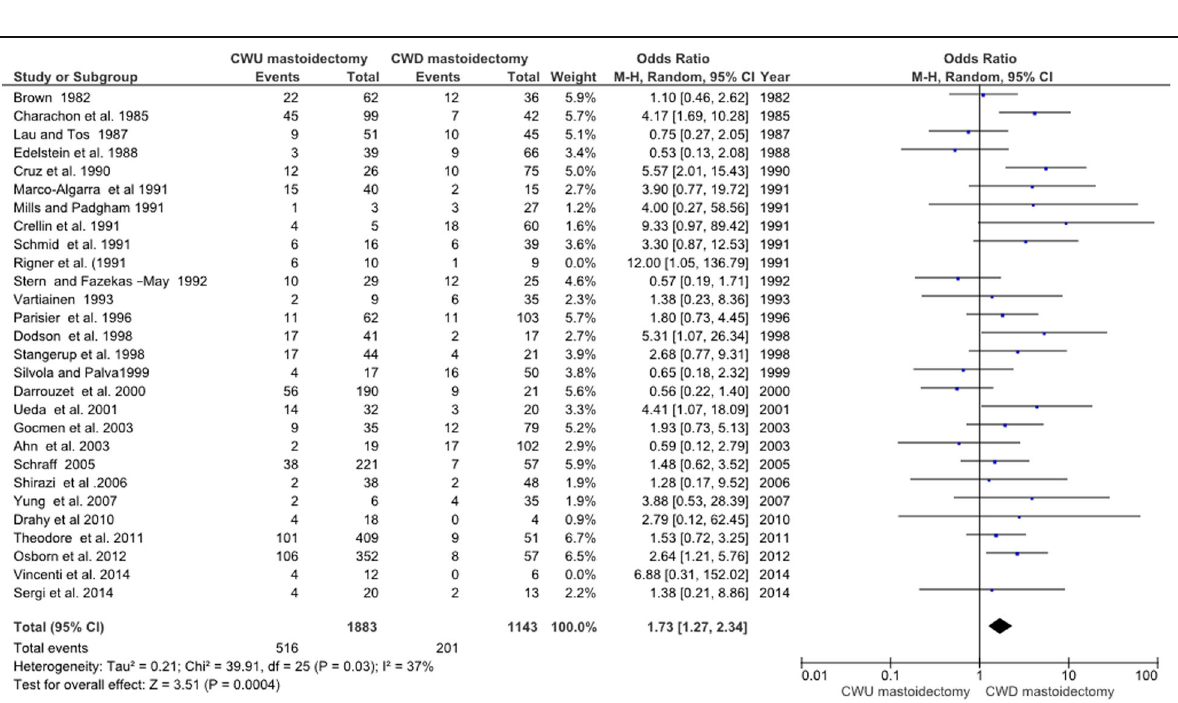
Fig. 3 Forest plot of analyzed data overall (after removing extreme